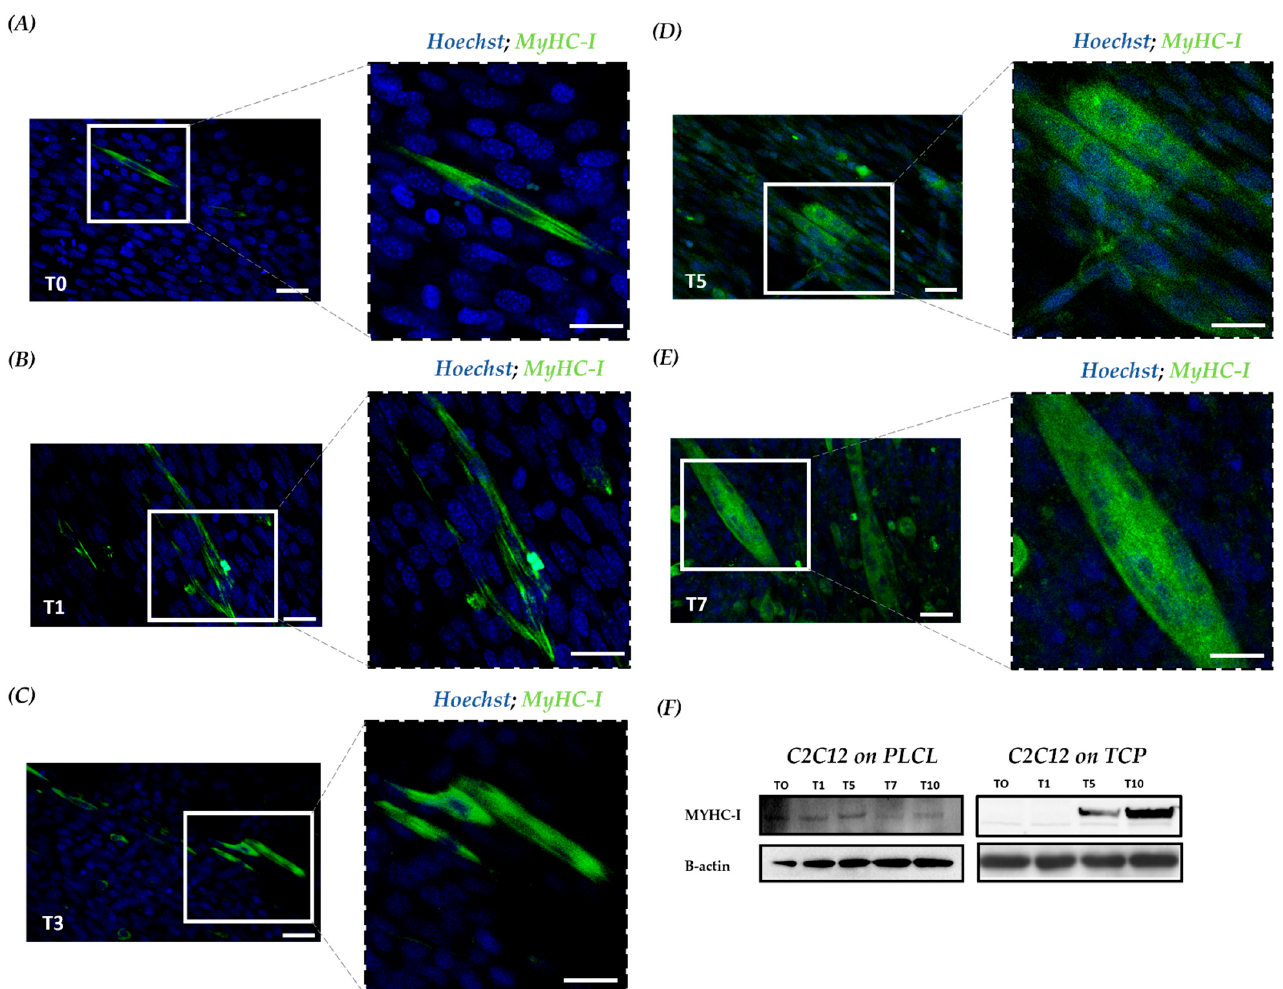
Figure 4. MyHC-1 expression during myogenic commitment of C2C12 on a scaffold. Confocal microscopy investigation with IF staining of the cell-based scaffold; MyHC-1 is indicated in green, and nuclei are counterstained with DAPI in blue. ( A ) At T0, undifferentiated cells only stained for nuclei in blue and differentiated with a cytoplasmic green signal positive for MyHC-1. Scale bars: 25 μ m and 10 μ m. ( B ) At T1, a progressive increase in differentiated cells positive for MyHC-1. ( C ) At T3, undifferentiated cells and fused myocytes with initial myotube formation. ( D )At T5, increasing number of myotube formation ( E ) At T7, mature multinucleated myotubes. ( F ) WB for MyHC-1 in total protein fractions; the bands were quantitated by calculating the relative quantities of MyHC-1 normalized to actin. Data are representative of three experiments and expressed as means.